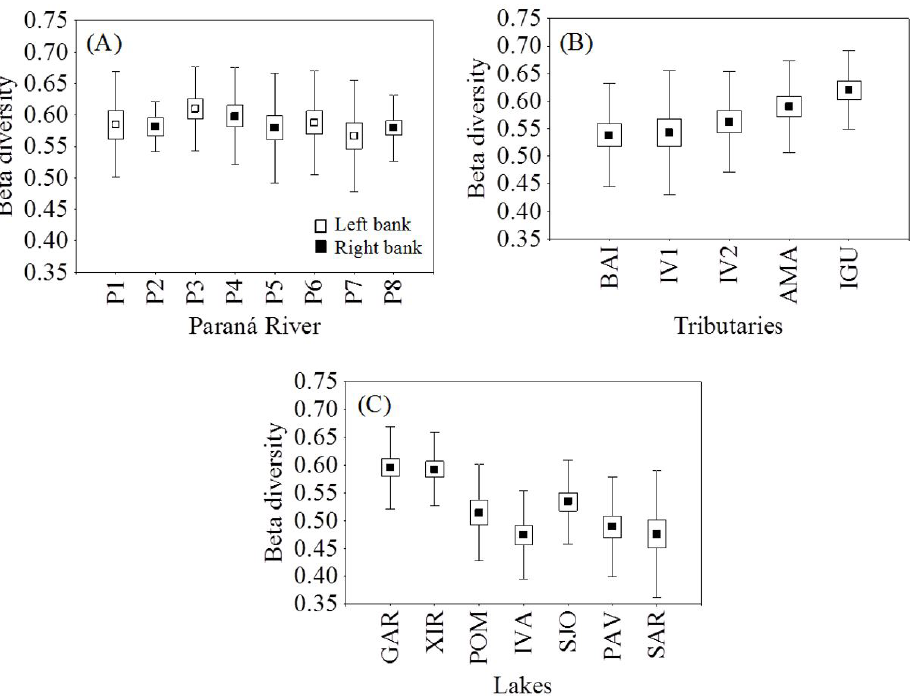
Figure 5. Mean values, deviation and standard error of beta diversity of ostracods in (A) Paraná River, (B) tributaries and (C) lakes in the river-floodplain system of the Upper Paraná River.